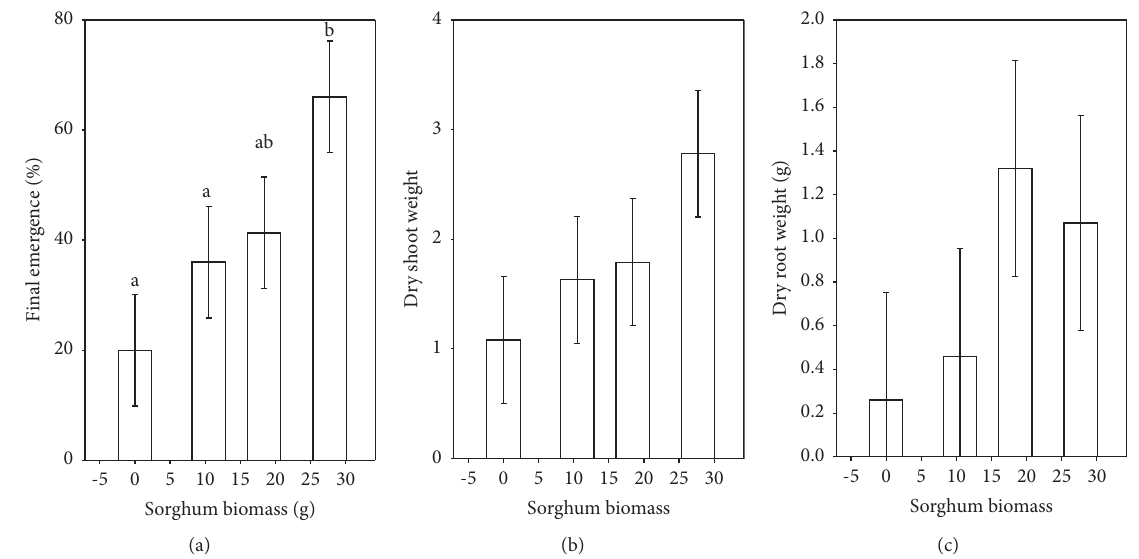
Figure 1: Effect of ground sorghum biomass on the final emergence (a), shoot dry weight (b), and root dry weight (c) of beggarticks. Bars indicated with different letters show that there were significant ( p < 0 . 05 ) differences between treatments. Error bars represent LSD at p < 0 .